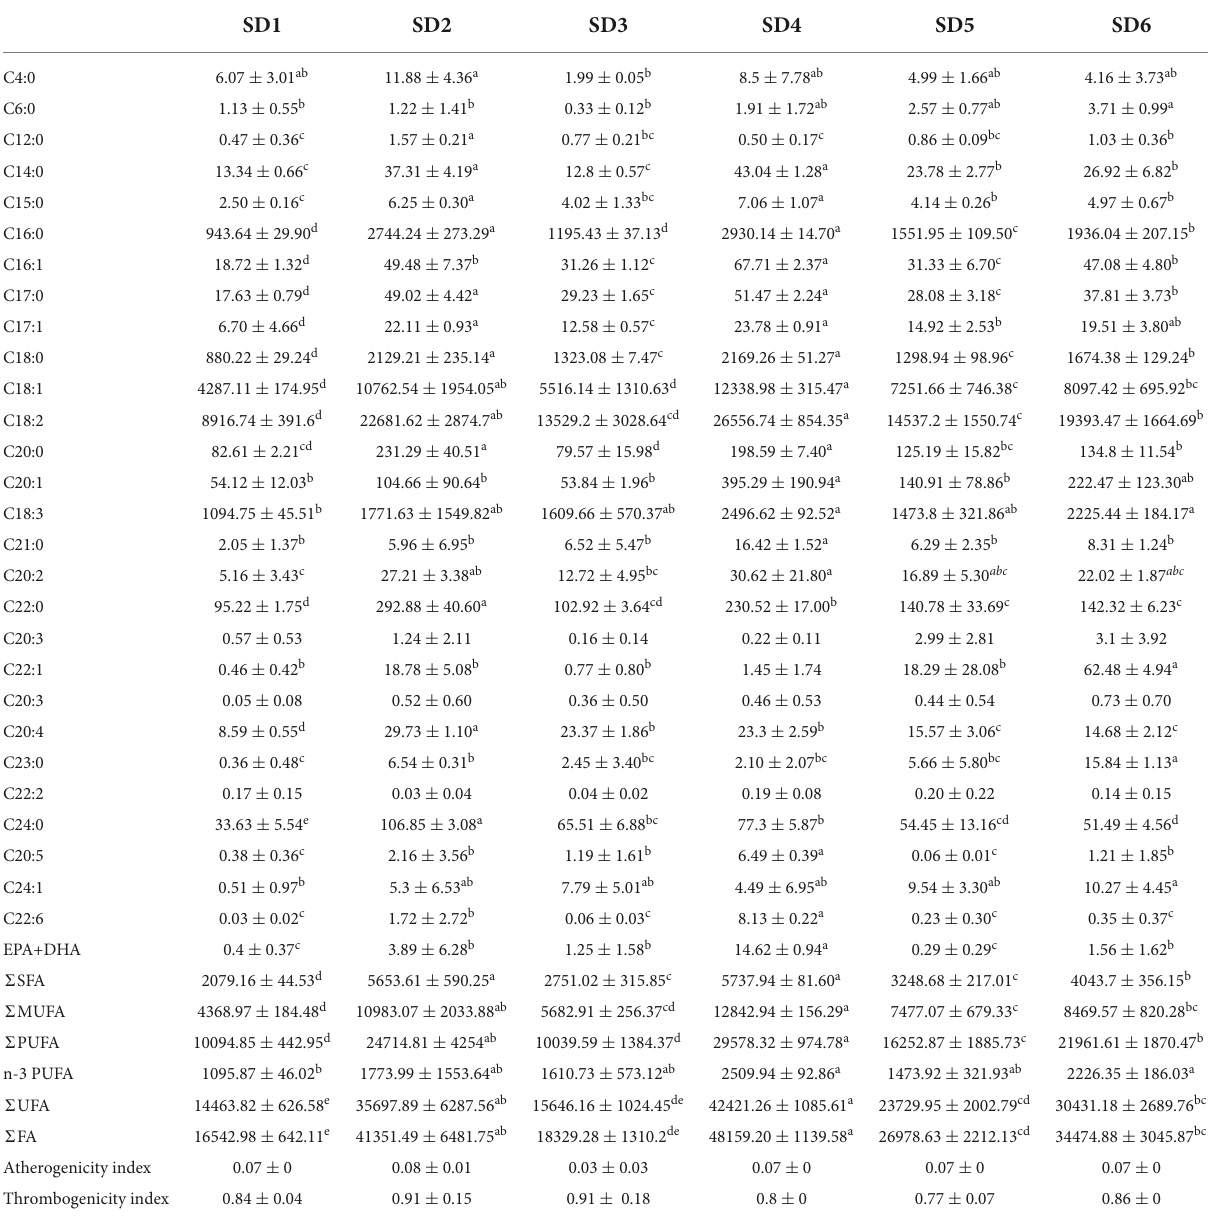
TABLE 4 Fatty acid composition and nutrition score of lipids in different sweet salad